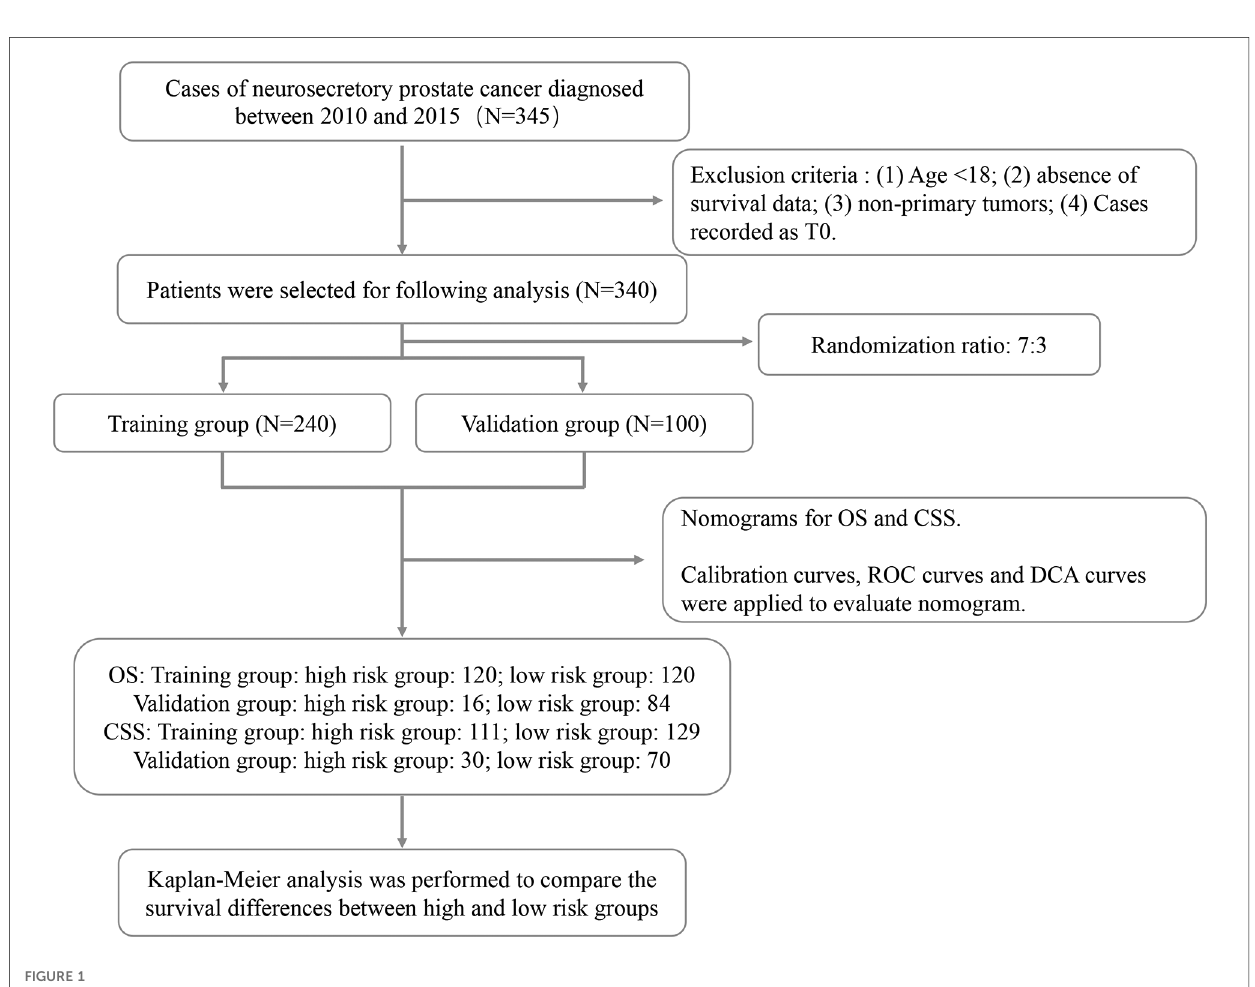
FIGURE 1 The fl ow chart of patient selection and data